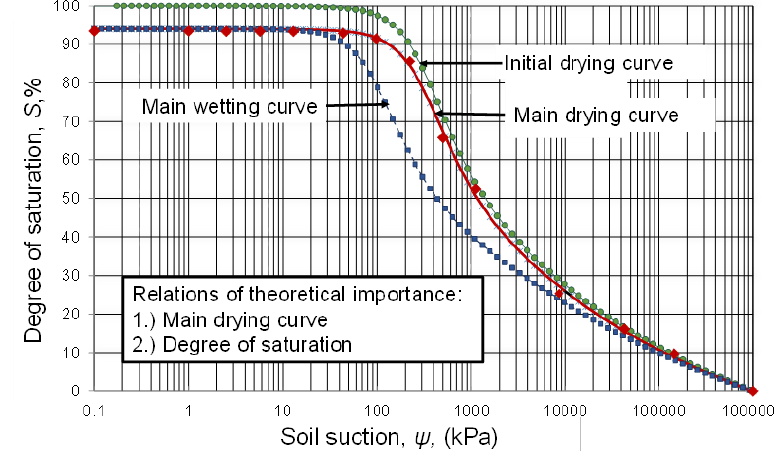
Figure 25. Family of degree of saturation soil-water characteristic curves [33,34].